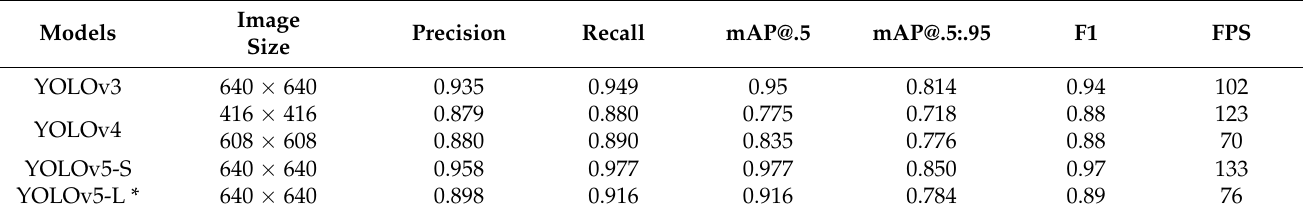
Table 3. The results of applying each training result model with the same test set.